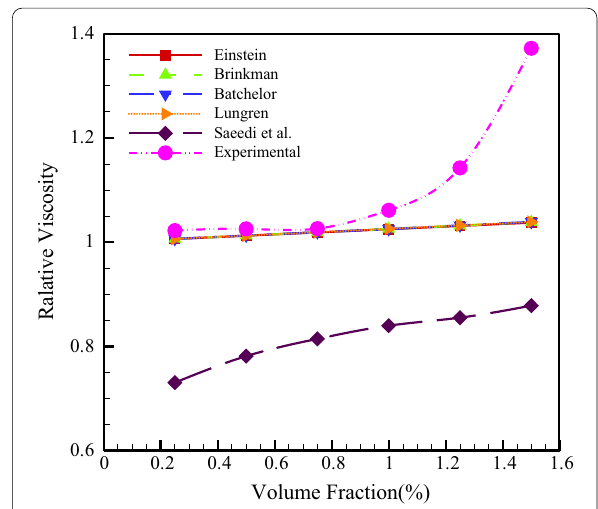
Fig. 13 Comparison of relative viscosity with different models